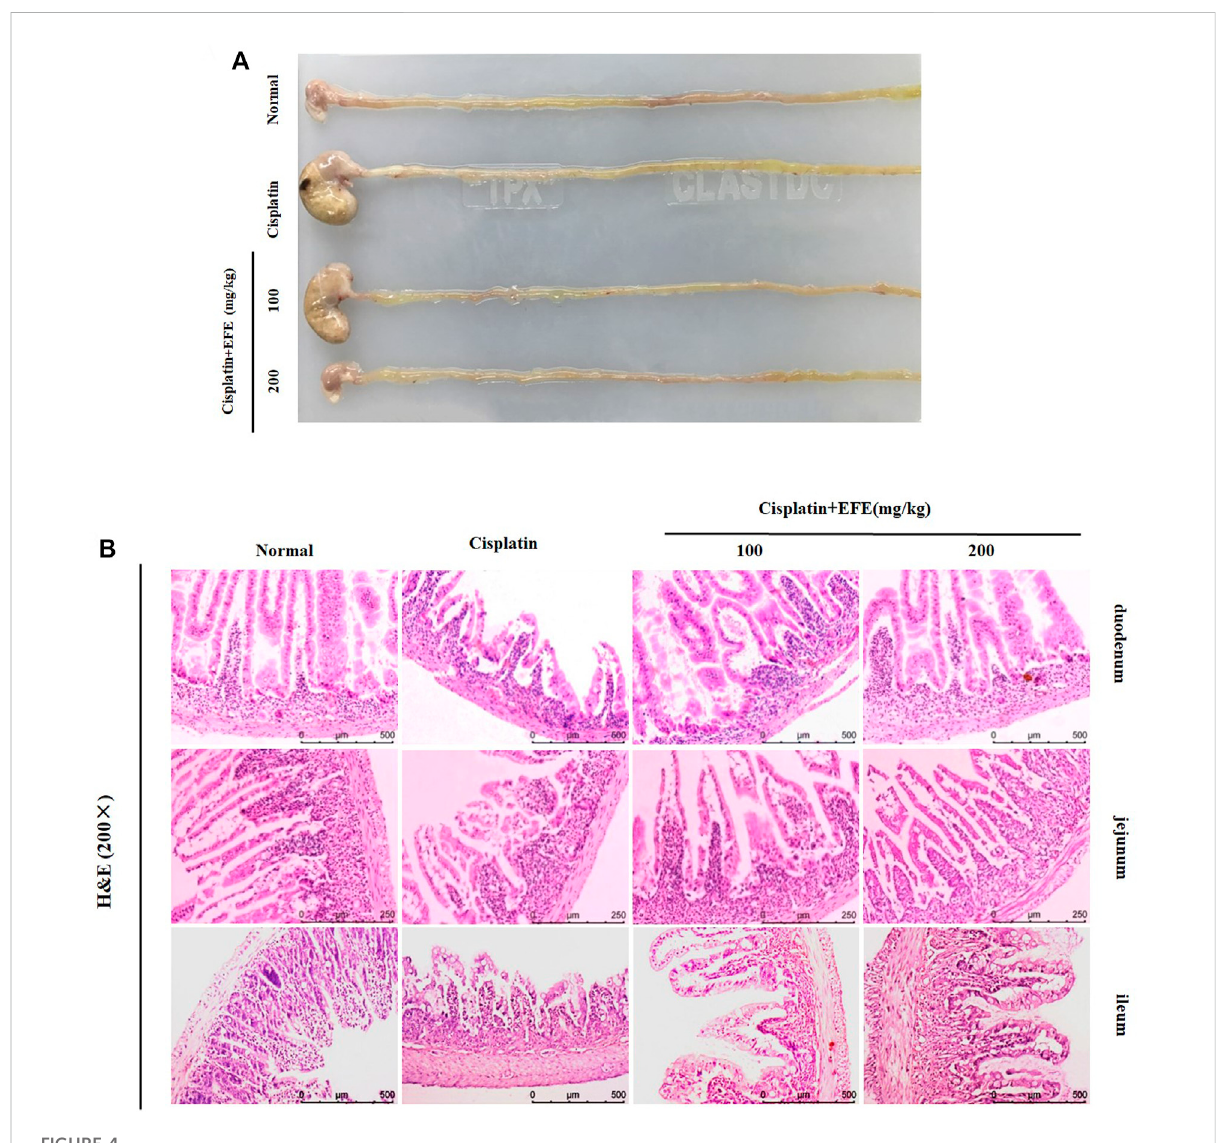
FIGURE 4 Effect of EFE on the gastrointestinal tissue morphology (A) of mice; Effect of EFE on intestinal histopathology in mice (B) . Note: Values are expressed as Mean ± S.D., ( n = 10). ## p < 0.01 vs. normal group; * p < 0.05, ** p < 0.01 vs. model